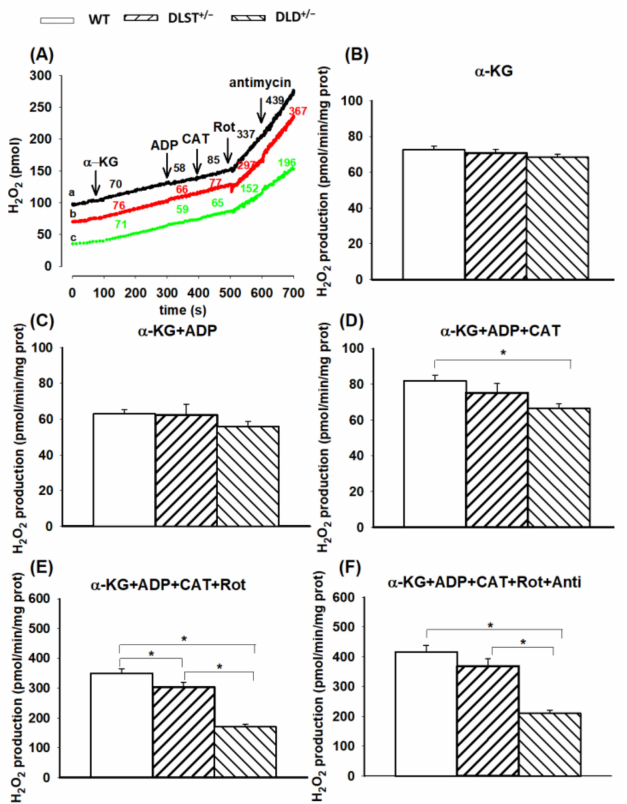
Figure 4. Hydrogen peroxide production in wild-type and KGDHc-subunit-KO mitochondria respir- ing on α -ketoglutarate. H 2 O 2 production was measured with the Amplex UltraRed assay as described under Materials and Methods. ( A ) Traces represent single independent experiments and are offset for clarity. Trace a (black): WT, trace b (red): DLST +/ − , trace c (green): DLD +/ − . Mitochondria (0.1 mg/mL) were incubated in the standard medium which was followed by the addition of α -KG (5 mM), ADP (2 mM), CAT (2 µ M), rotenone (Rot, 250 nM), and antimycin A (1 µ M), as indicated. Numbers on the traces represent rates of H 2 O 2 generation expressed in pmol/min/mg protein. H 2 O 2 production was measured in the presence of α -KG ( B ) and after adding ADP ( C – F ), CAT ( D – F ), Rot ( E , F ) and antimycin A ( F ). Results are expressed as means of rates of H 2 O 2 production in pmol/min/mg protein ± S.E.M. ( N = 4–14). All other representations are as in Figure 1 . Statistically, significant differences are indicated by asterisks; * p <